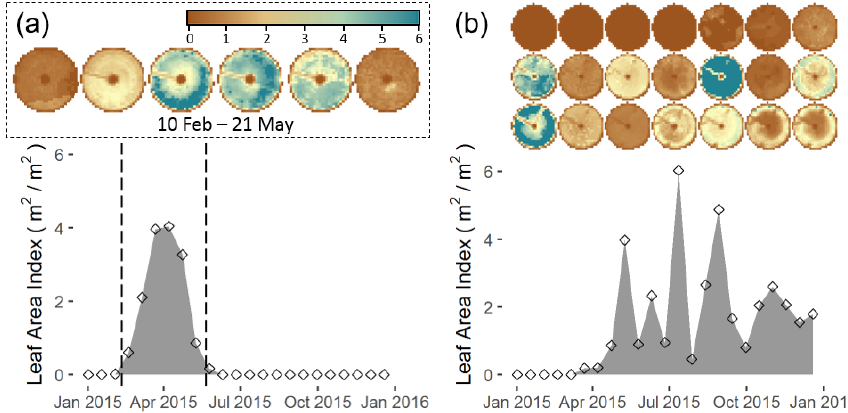
Figure 4. Example of two types of crops identified for this study based on an LAI threshold of 0.3m 2 m − 2 . (a) Images of the six scenes when the field was identified as active are shown on top, which correspond to the six dates marked as diamonds inside the dashed lines in the bottom plot. The season start and end dates (10 February and 21 May) correspond to dates when the mean LAI crosses the threshold of 0.3m 2 m − 2 . (b) This particular field was inactive during the first 3 months of the year, followed by large LAI oscillations, indicating repeat cut/re-growth activities. Landsat scenes for this field are shown on top, increasing in date to the right and bottom, while the dates are marked as diamonds in the LAI time series